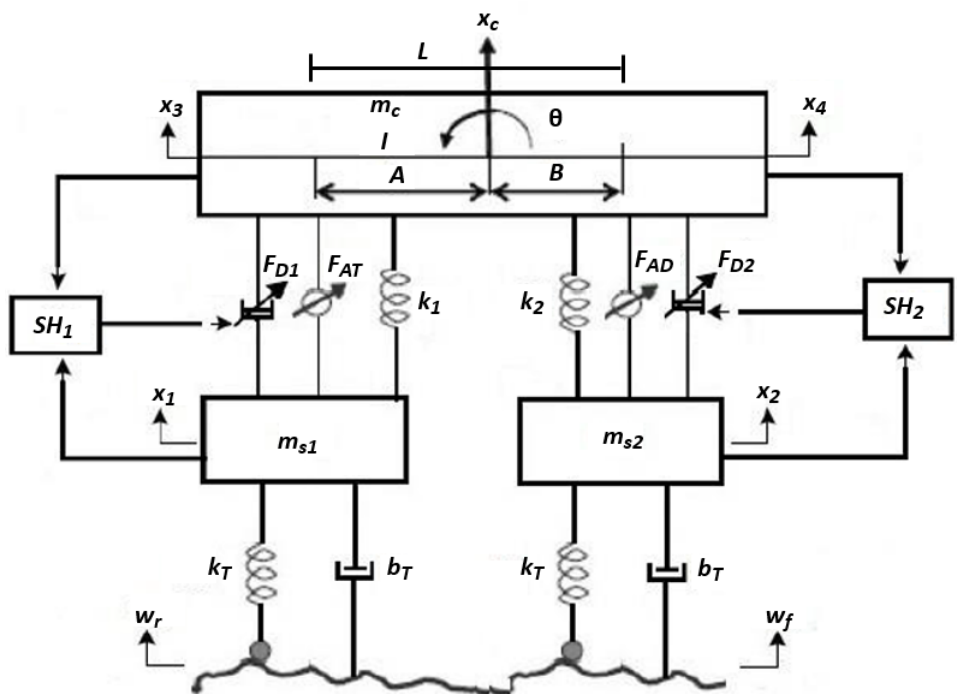
Figure 6. Half-car semi-active suspension model proposed to lift the vehicle chassis in the presence of